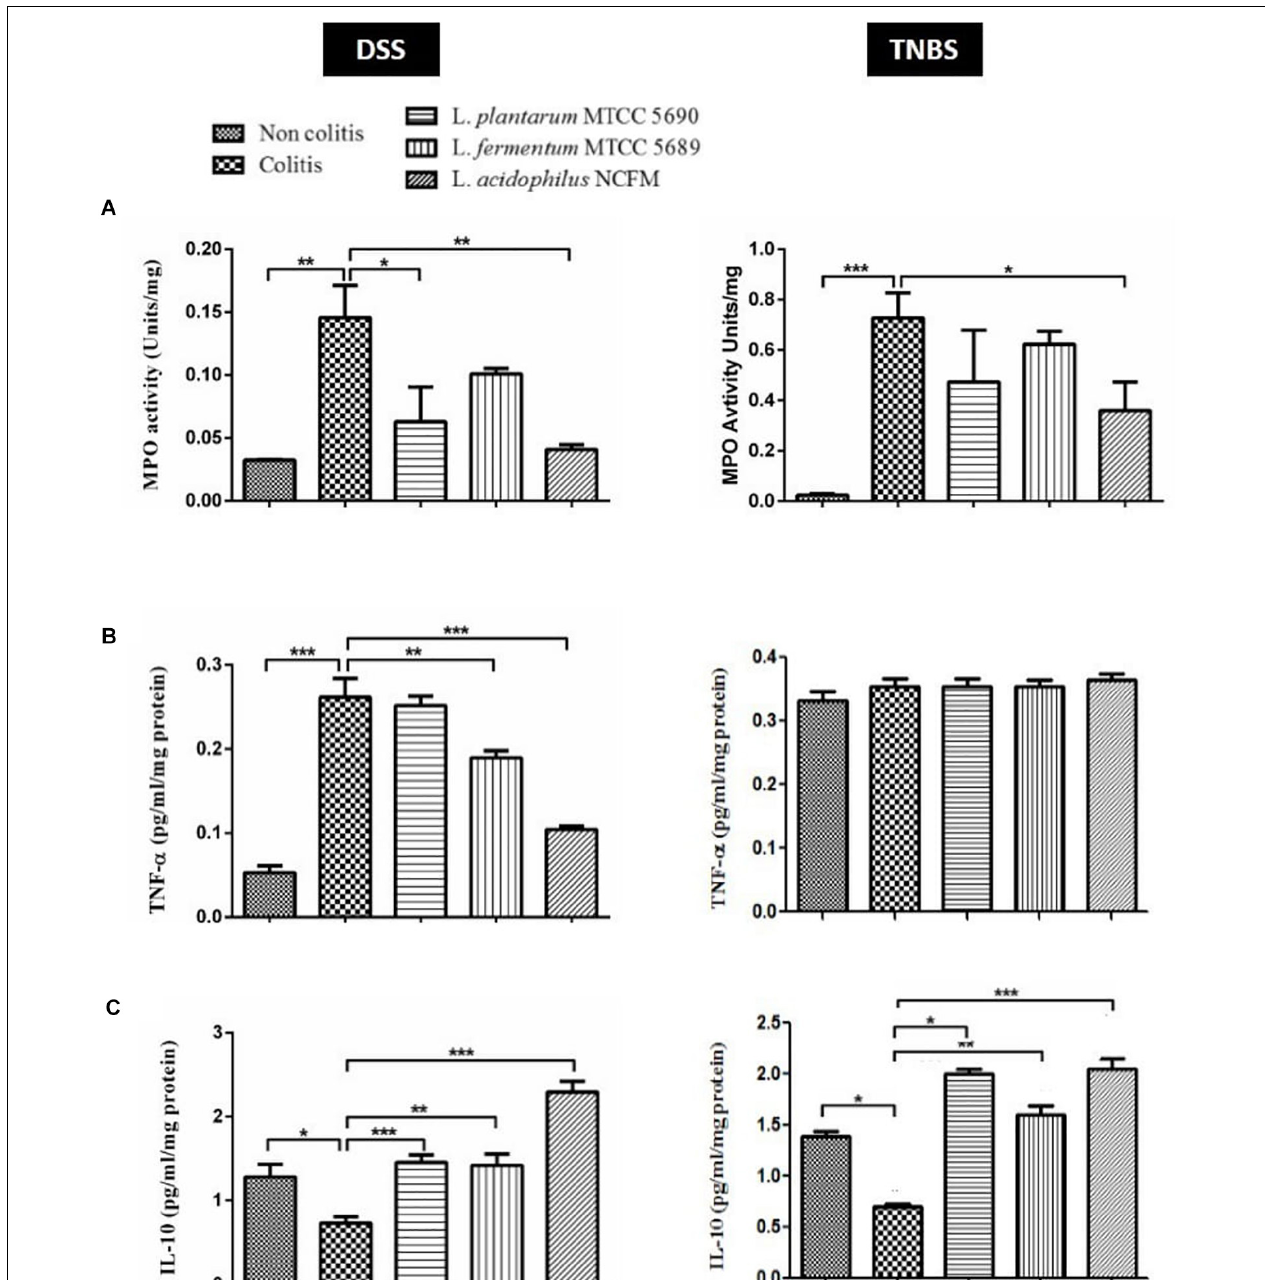
FIGURE 4 | Comparative evaluation of immunomodulatory effects of surface proteins from test probiotic strains in reducing DSS and TNBS induced colitis; (A) MPO Activity; (B) TNF- α estimation; (C) IL-10 estimation * P < 0.05; ** P < 0.01; *** P <